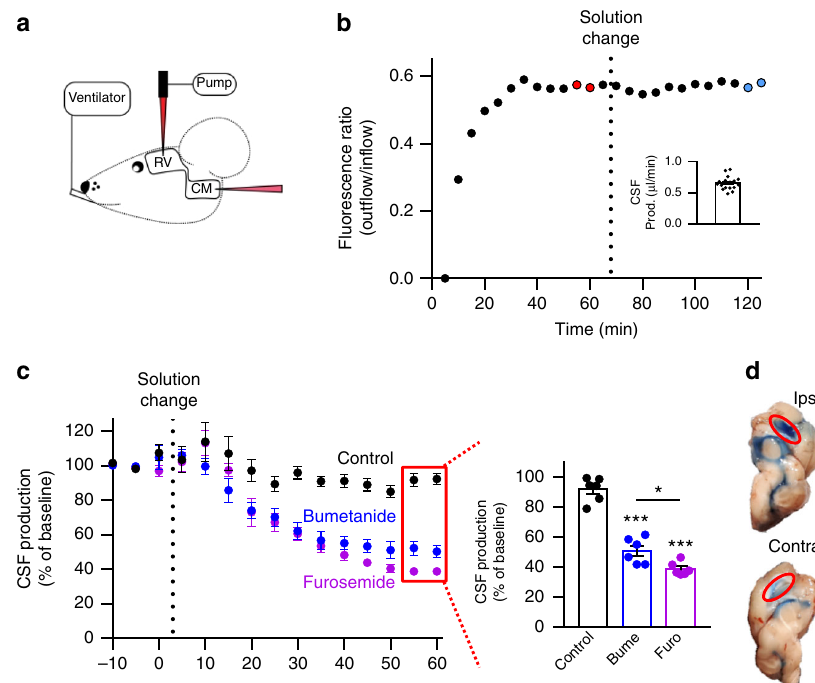
Fig. 5 NKCC1 acts as a signi fi cant contributor to in vivo CSF production. a Schematic drawing of the infusion of aCSF containing dextran (dark red cannula) into the right lateral ventricle (RV) and collection of the diluted dextran (light red cannula) at cisterna magna (CM) of a ventilated mouse. b Representative time course of the fl uorescence ratio of dextran (out fl ow/in fl ow) during a control ventriculo-cisternal perfusion. After stable baseline (60 min), the dextran/DMSO aCSF-solution was changed within 5 – 10 min. Inset depicts the average CSF production rate ( n = 18 mice). c Summarized data from ventriculo-cisternal perfusion illustrating CSF production (percentage of baseline) as a function of time. Data normalized to the average of the two last samples before solution change. Control perfusion with the DMSO-vehicle is shown in black ( n = 6 mice), treatment with bumetanide in blue ( n = 6 mice), and furosemide (n = 6 mice) in purple. Inset illustrates the summarized CSF production rates after 60 min exposure to vehicle (black), bumetanide (blue), or furosemide (purple) normalized to own control. d Mid-sagittal section of a mouse brain after unilateral injection of Evans Blue revealed staining mainly in the injected, right lateral ventricle (top panel) compared to the contralateral ventricle (bottom image). Error bars represent standard error of the mean and statistical signi fi cance was tested with one-way ANOVA followed by Tukey ’ s multiple comparisons test with asterisks above the bars indicating comparison to control perfusion and comparison between test solutions indicated by lines above the respective bars. * P < 0.05, *** P <